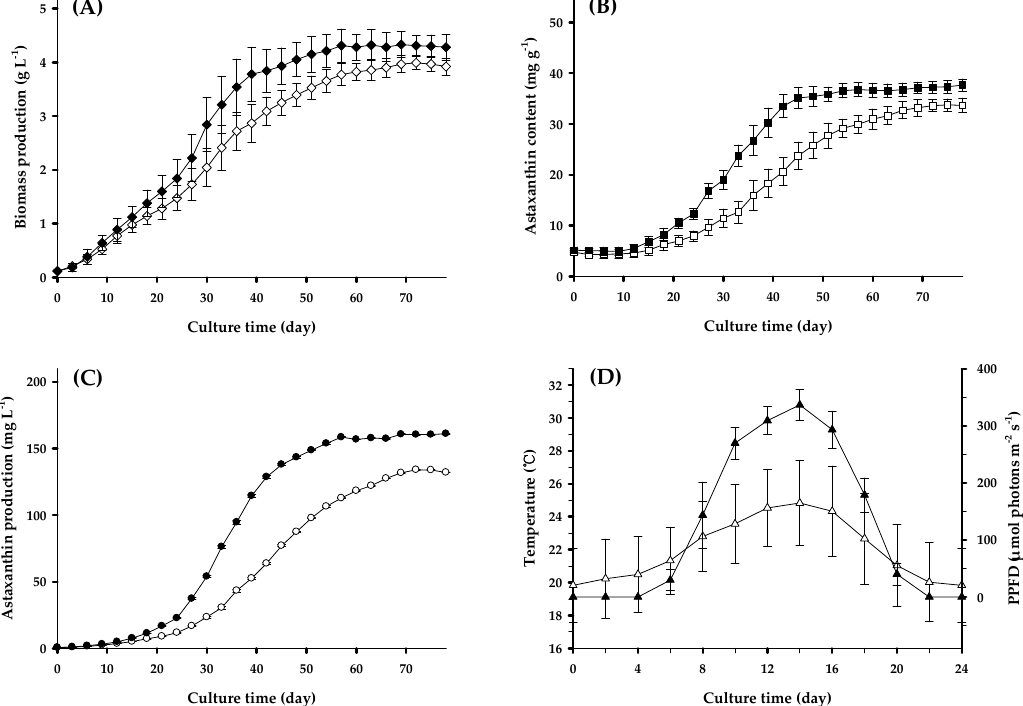
Figure 3. Comparison of ( A ) biomass production (diamond), ( B ) astaxanthin content (square), and ( C ) astaxanthin concentration (circle) from H. pluvialis cells of wild type (white) and the mutant PP-PS 160 (black) under moderate temperature conditions in spring. ( D ) Photosynthetic photon flux density (PPFD) (black triangle) and medium temperature (white triangle) during the daylight period in spring (March–May). Each value is mean ± standard deviation of three replicates.